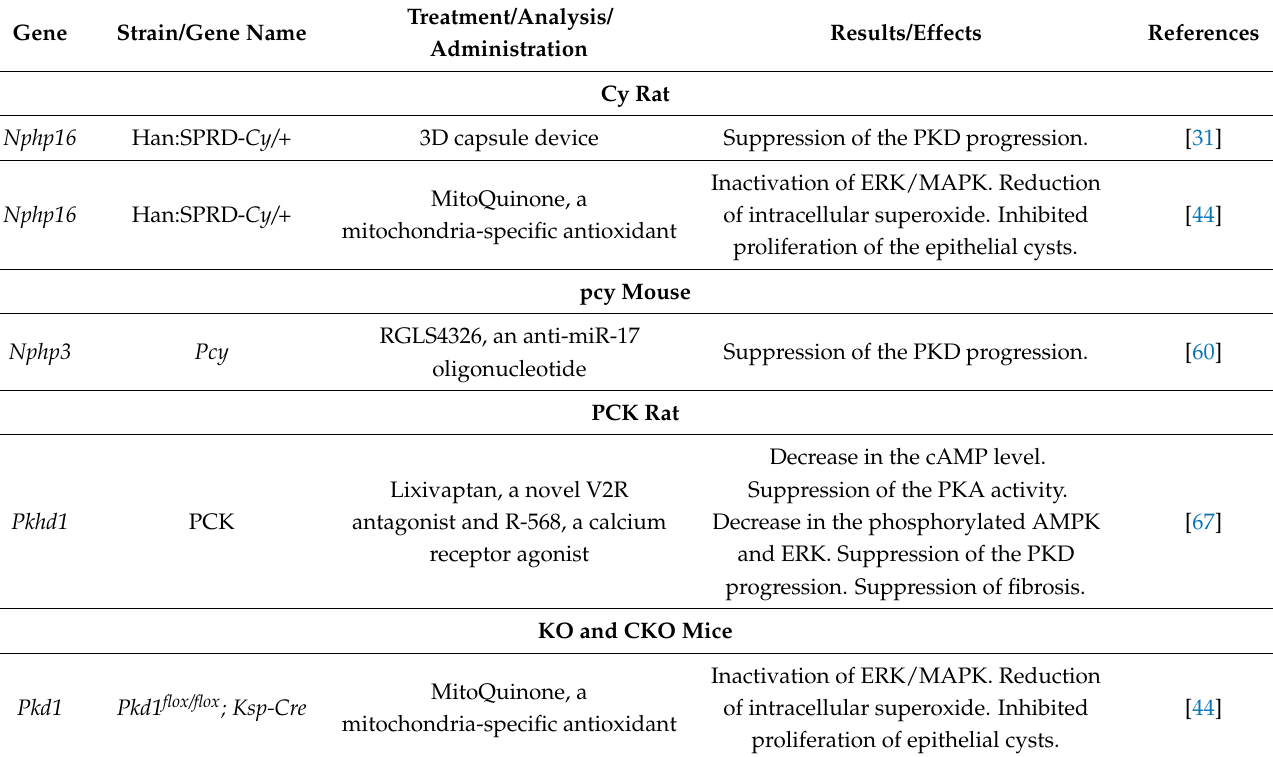
Table 1. Animal models and their applications are based on recently reported novel findings. Treatment/Analysis/ Gene Strain/Gene Name